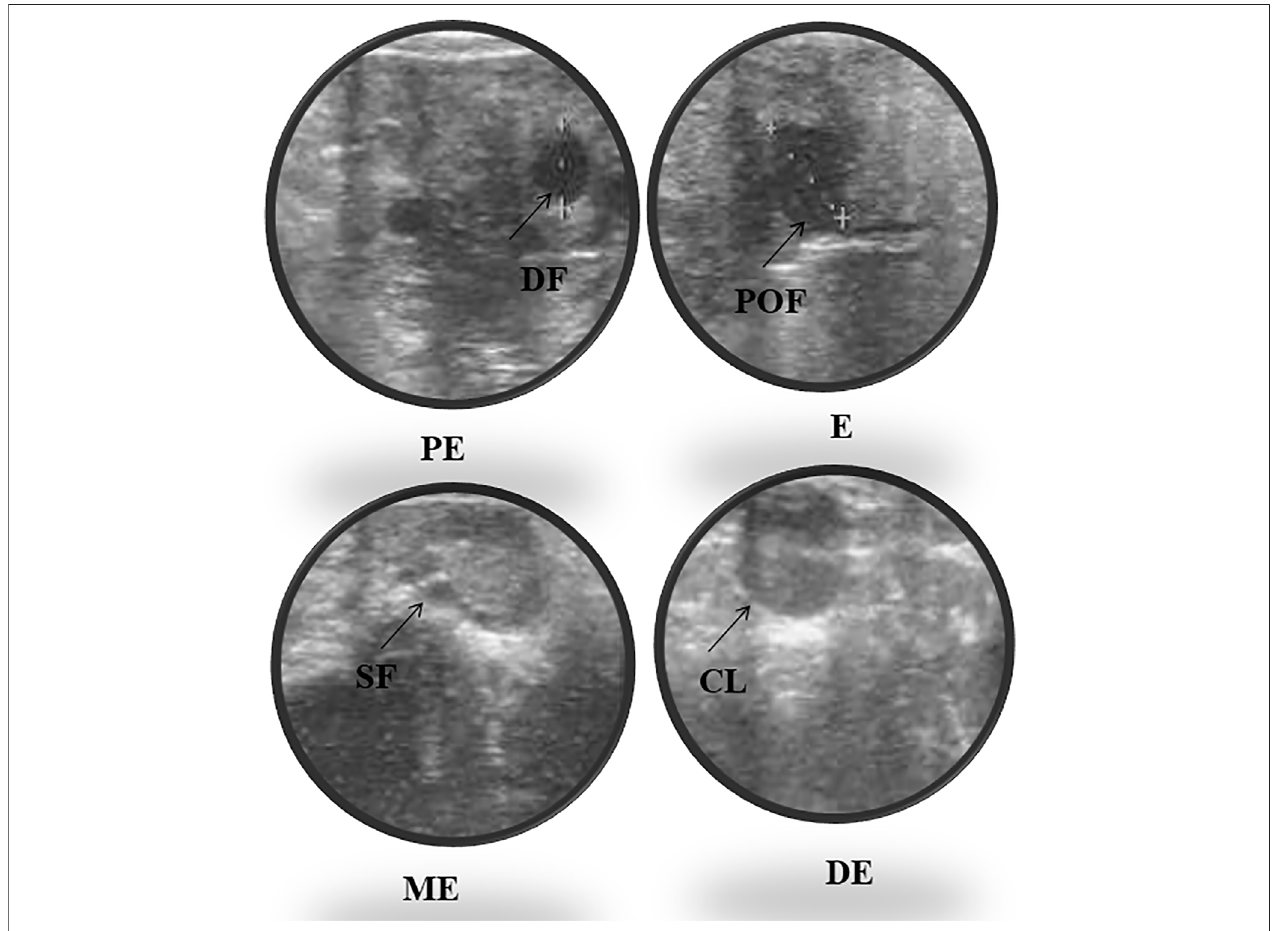
FIGURE 5 | Ultrasonography of ovarian follicles and corpus luteum (CL) during proestrus (PE), estrus (E), metestrus (ME), and diestrus (DE) stages of the buffalo estrous cycle (DF, dominant follicle; SF, small follicle; POF, preovulatory follicle; CL, corpus luteum).